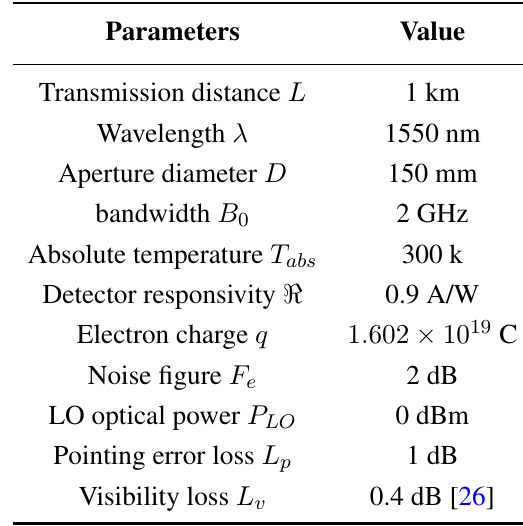
Table 1. Numerical parameters. LO, local